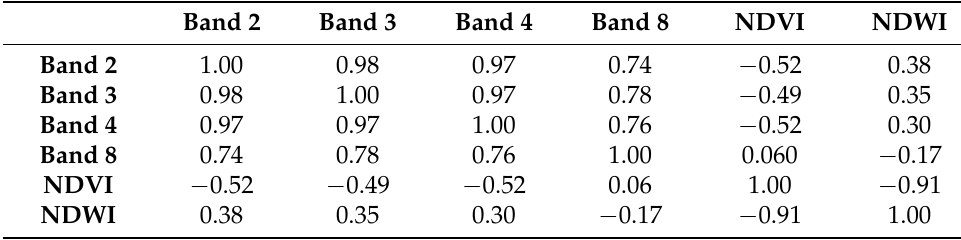
Table 4. Pairwise Pearson correlation coefficient for input